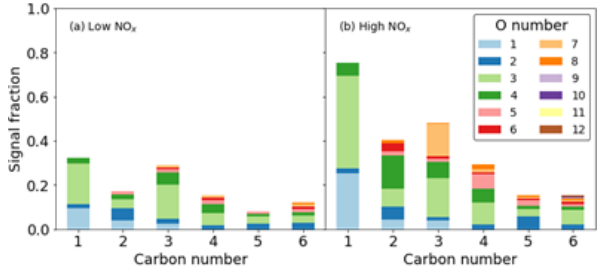
Figure 11. Signal fraction as a function of carbon number for ring- breaking products for the (a) high-NO x and (b) low-NO x condi-